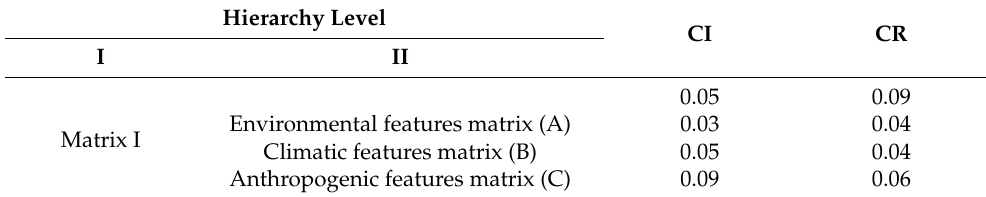
Table 3. A summary of CI and CR indices for the paired comparison